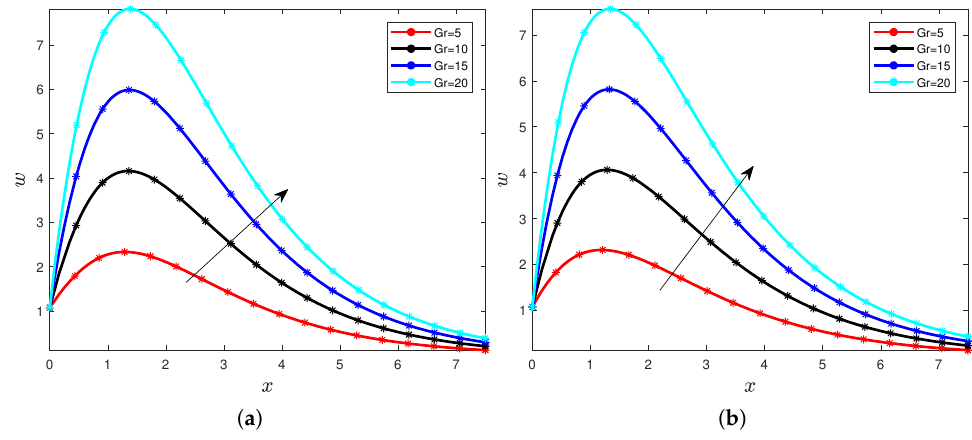
Figure 5. Velocity for different values of the Casson parameter η = 0 ( a ) and η = 0.3 ( b ).